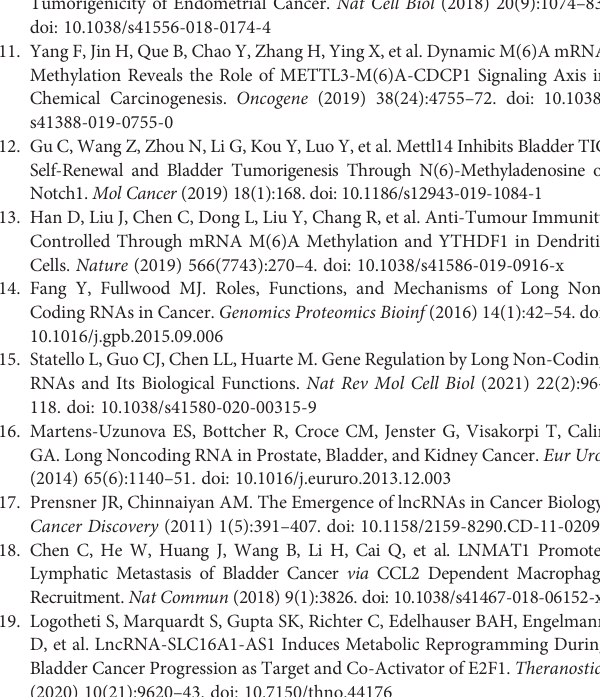
Supplementary Figure 1 | The mRNA expression levels of 23 m6A regulators in bladder cancer and normal control samples in TCGA and GTEx datasets. Wilcoxon test was used for comparison. * P <0.05, ** P <0.01, *** P <0.001. Supplementary Figure 2 | Kaplan – Meier curves of the 12 m6A-related lncRNAs for overall survival. Best cut-off value used for grouping was determined by the “ sur_cutpoint ” function. Supplementary Figure 3 | The SRAMP prediction of m6A methylation site on the 12 m6A-related